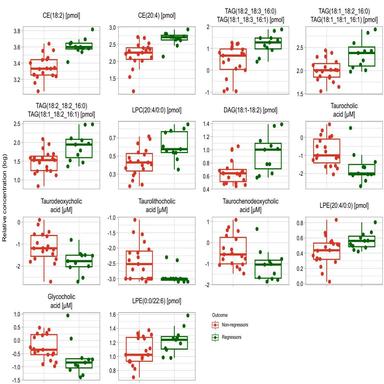
Statistically significant lipids differentiating non-regressors (red) vs. regressors (green), validated in external validation cohort. Bile acids, the main predictors; taurocholic acid and taurochenodeoxycholic acid were significantly decreased in regressors, whereas other lipids such as TAGs, DAGs, CE and LPL were significantly increased. The association of each marker is tested by an analysis of deviation of a logistic regression and corrected for multiple-testing by the estimation of Benjamini-Hochberg f